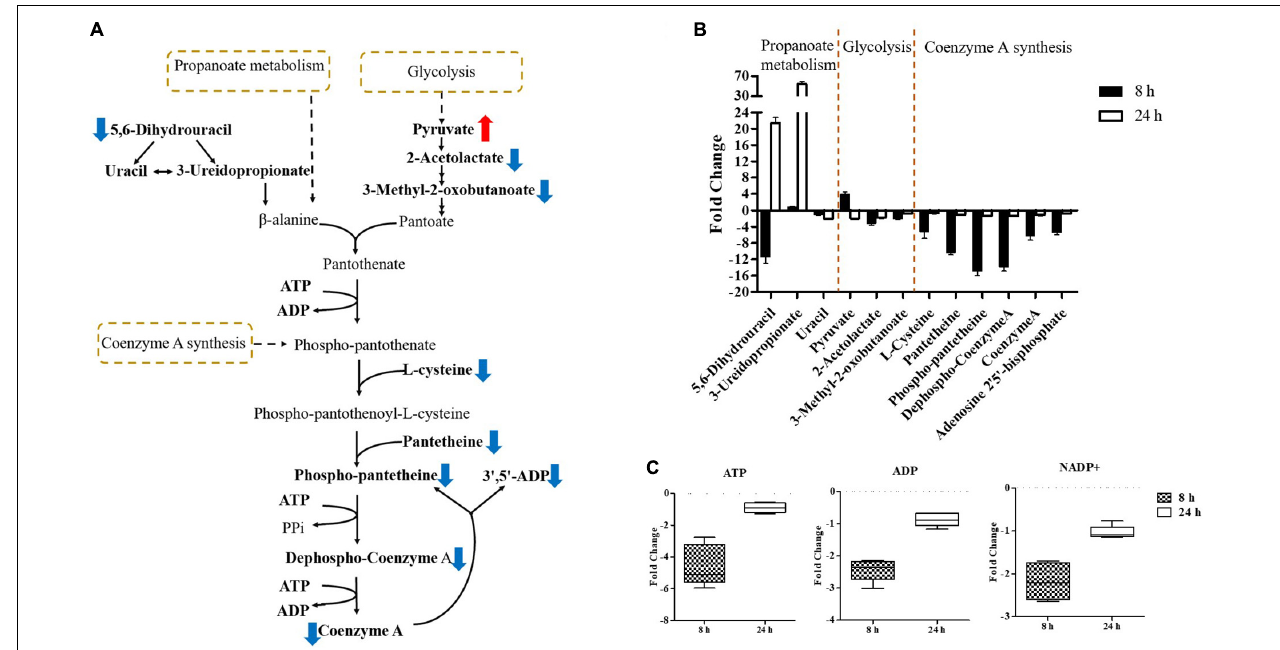
FIGURE 8 | Central metabolic changes in pantothenate and CoA biosynthesis. (A) In the pathway flow charts (adapted from KEGG Pathway with reference to E. coli K-12), red arrows and blue arrows indicate that the metabolites were significantly increased or decreased, respectively. (B) Metabolites associated with this pathway and (C) decreased levels of key energy-associated metabolites in E. coli TOP10 with over-expression of mcr-1 at 8 and 24 h. FDR < 0.05, p < 0.05 and fold change ≥